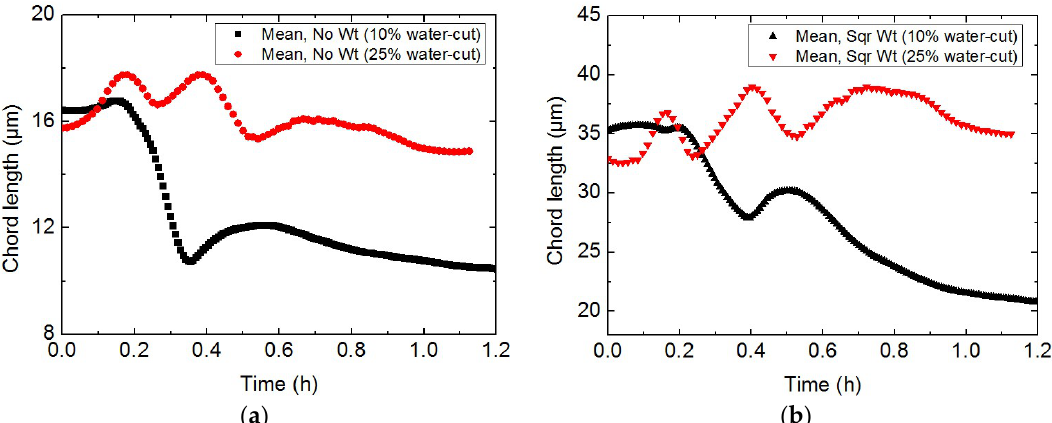
Figure 10. Influence of water-cut on chord length during the hydrate dissociation ( a , b ). ( a ) Influence of water-cut on mean chord length (5 MPa, 1.0 m/s); ( b ) influence of water-cut on square-weighted chord length (5 MPa, 1.0 m/s).